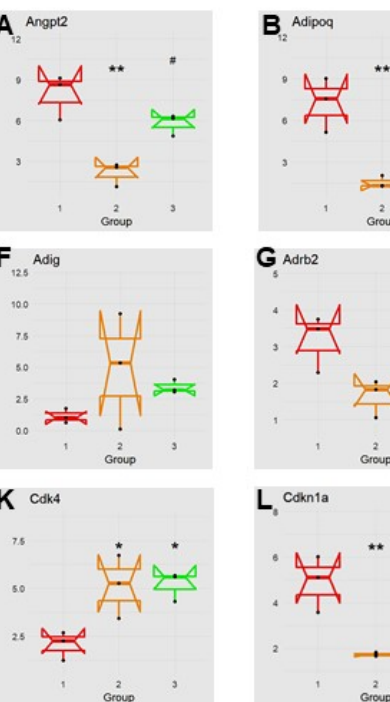
Figure 9. Improved expression of mitochondrial proteins in the heart of shNOV-treated mice (NOV